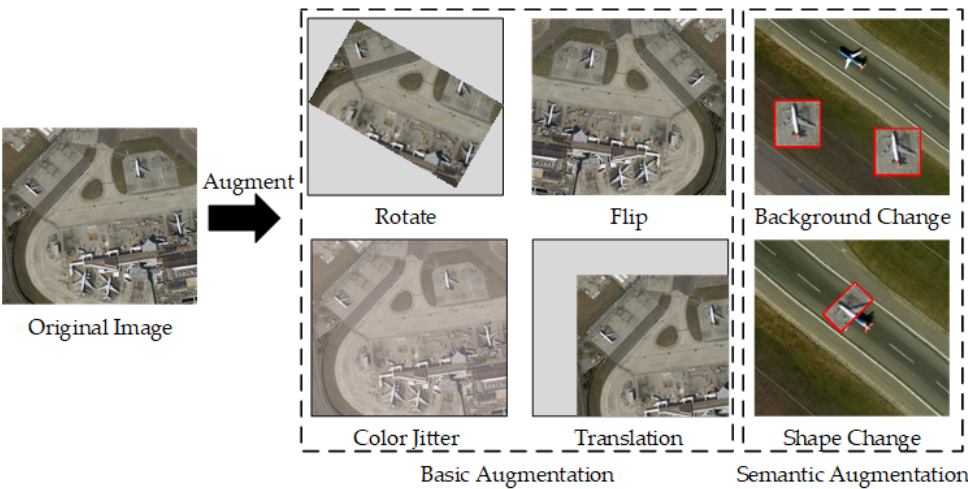
Figure 1. Basic training data augmentation methods.